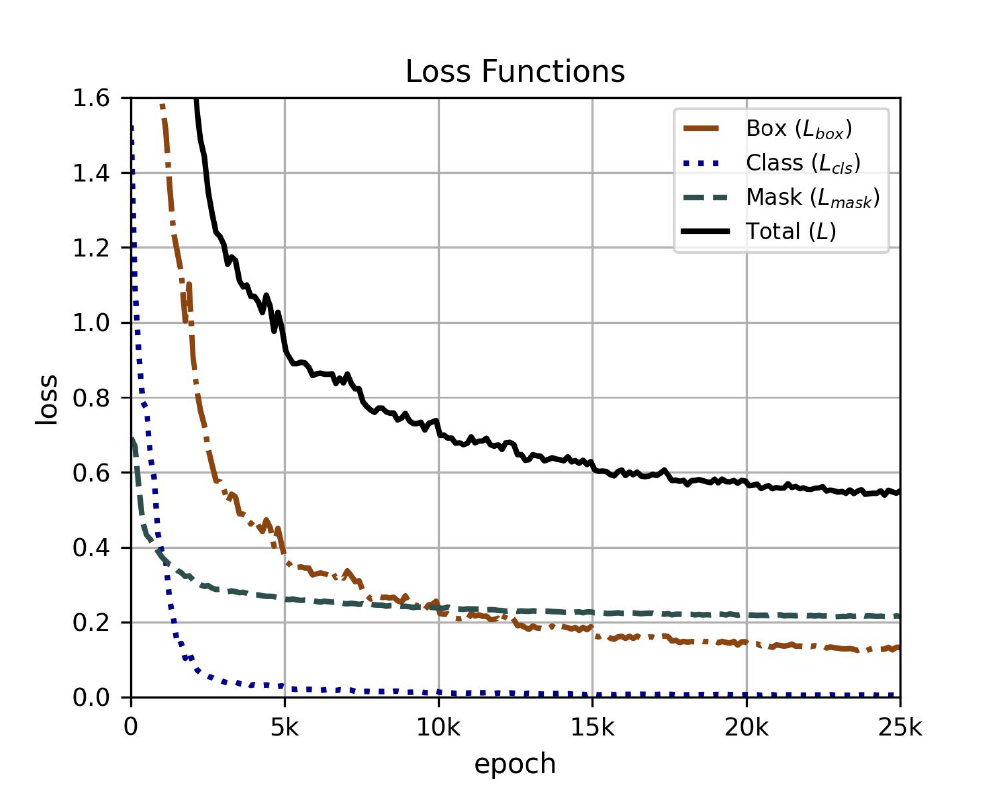
Figure 7. Loss function’s behavior throughout training